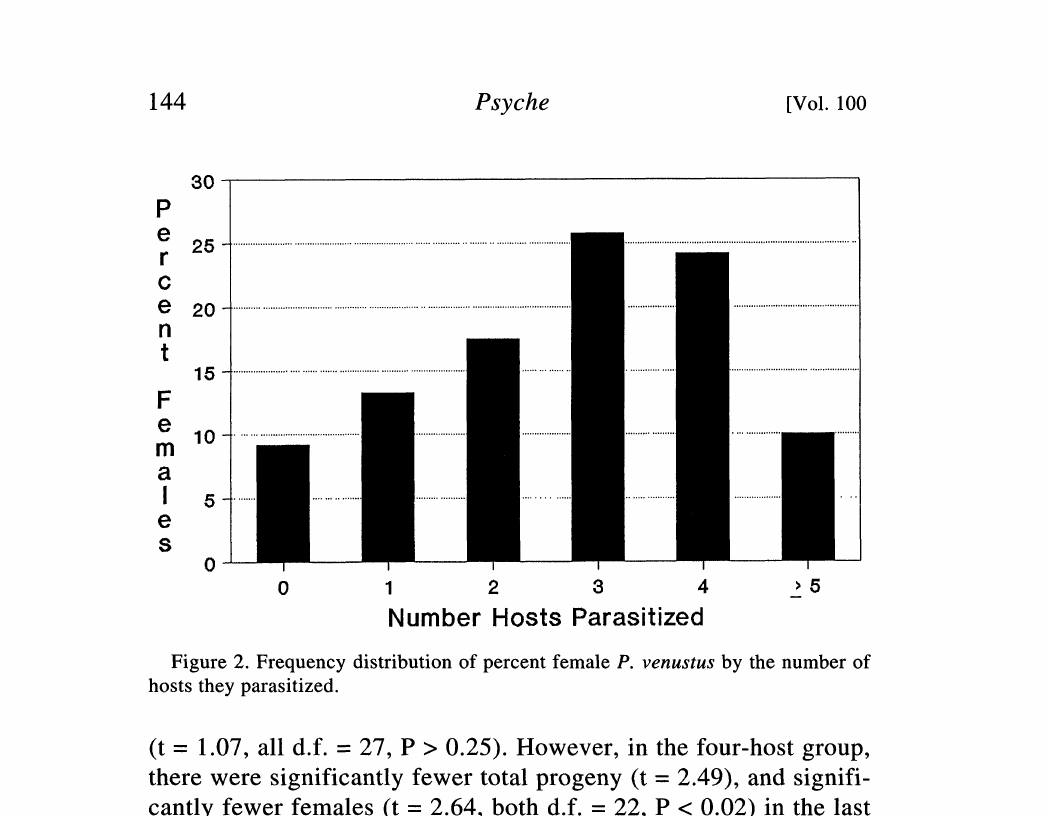
Figure 2. Frequency distribution of percent female P. venustus by the number of hosts they parasitized. (t 1.07, all